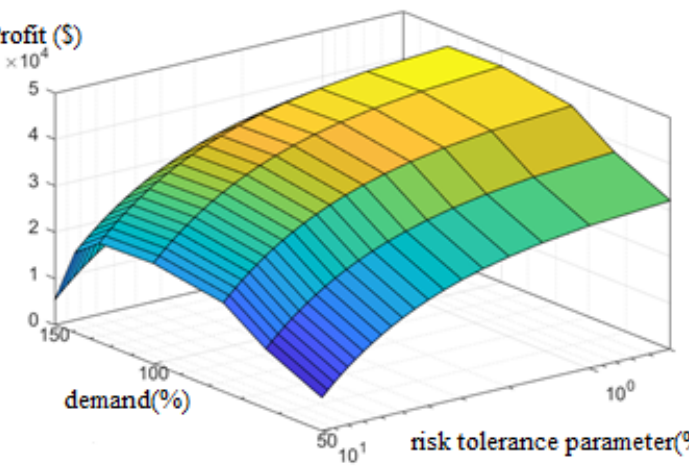
Figure 3. Profit diagram of bidding demand in Case 1.